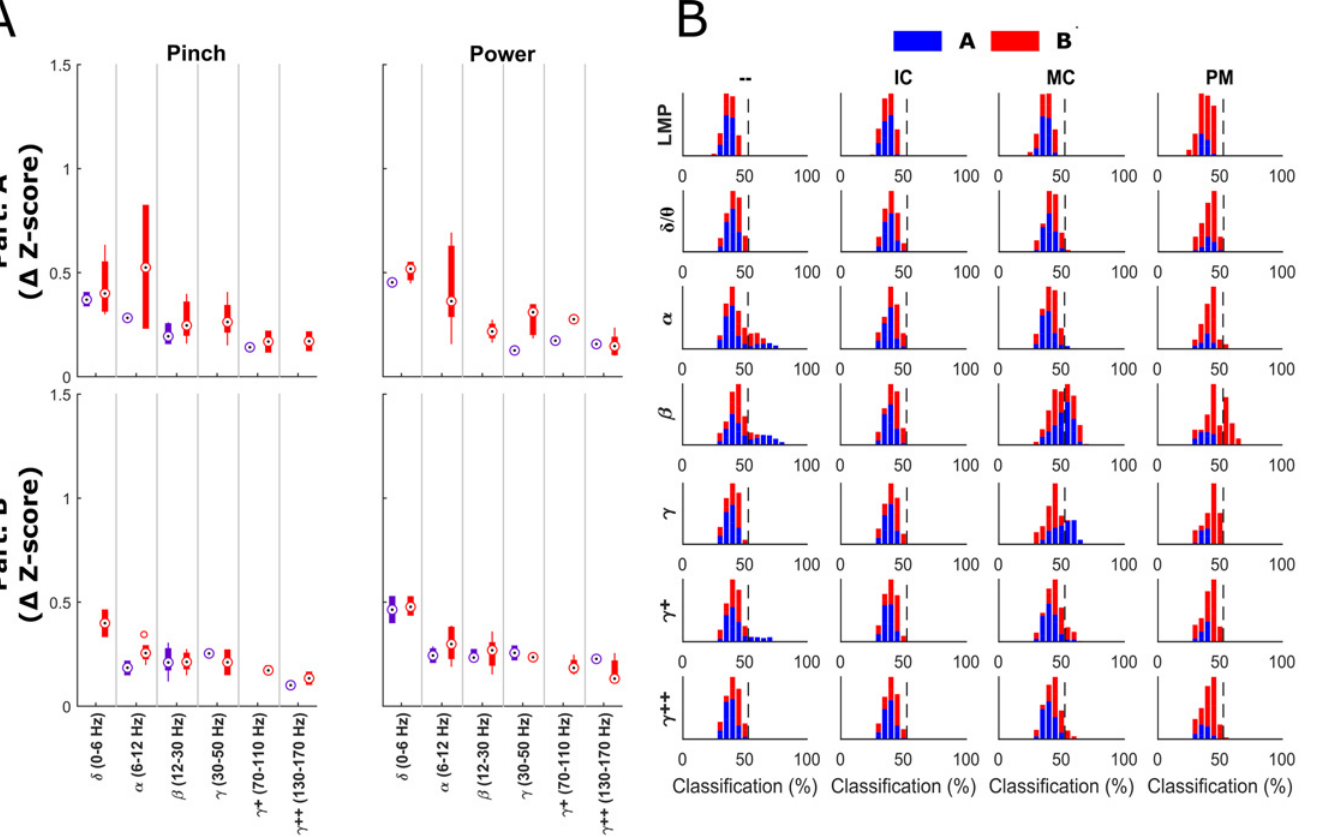
Fig 6. Imagined single feature modulation. Panel A shows the mean ± standard deviation depth of modulation (change in z-score from baseline) for statistically significant MC (red bars) and IC (purple bars) channels, organized by participant (rows) and by frequency band (x-axis) for each of the two imagined force grasping configurations. Modulation was lower as a whole during imagination compared to Fig 3B with the exception of the alpha band for participant A. Panel B shows single feature classification distributions for imagined force versus rest trials. Participant A is shown in blue and participant B is shown in red. The chance level is shown as the dotted line. Histograms are arranged by frequency band (rows) and by brain region